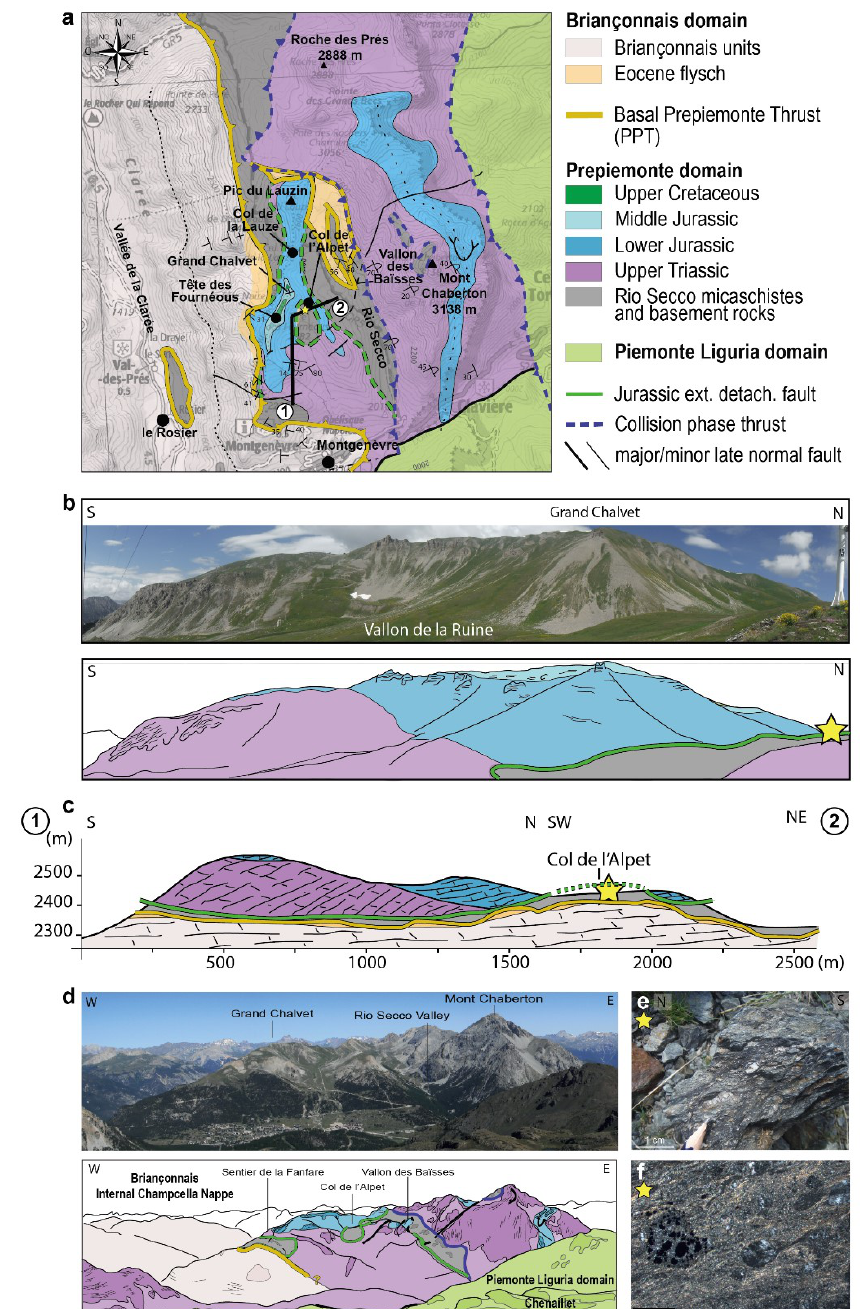
Figure 9. ( a ) map of the Grand Chalvet area showing the location of section (1)–(2) shown in panel ( c ) and the location of the black gouges (yellow star) shown in panels ( e , f ); ( b ) Panoramic view across the “Crête du Grand Chalvet” and the “Col de l’Alpet” and ( c ) its geological interpretation showing the relationship between the Briançonnais and Prepiemonte units. The zone containing slivers of basement with black gouges (green line) is interpreted as a reactivated Jurassic extensional detachment fault. It truncates internal structures of the Grand Chalvet; ( d ) Panoramic view of the Grand Chalvet Mont Chaberton area showing the Prepiemonte domain and the Basal Prepiemonte Thrust (PPT). The green line traces remnants of basement containing gouges, which are interpreted as relics of a reactivated Jurassic detachment system; ( e , f ): macroscopic and microscopic view of the black gouge within the basement at Col de